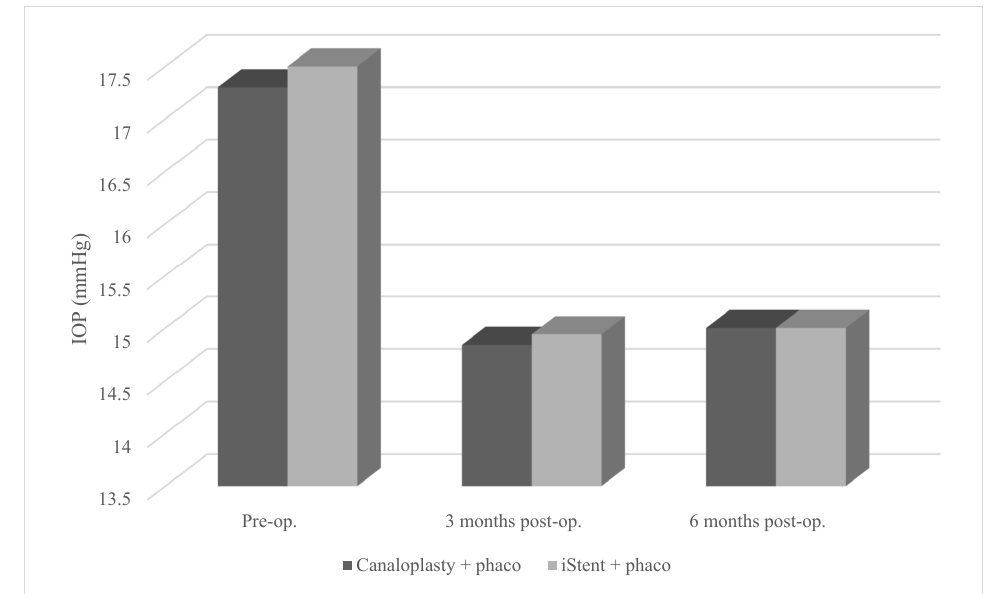
8 of 16 Table 5. Comparison of antiglaucoma medications according to type of surgery–baseline vs. further measurements. Variable